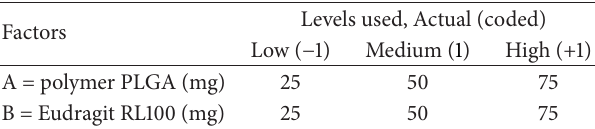
Table 1: Factorial design parameters and experimental condition